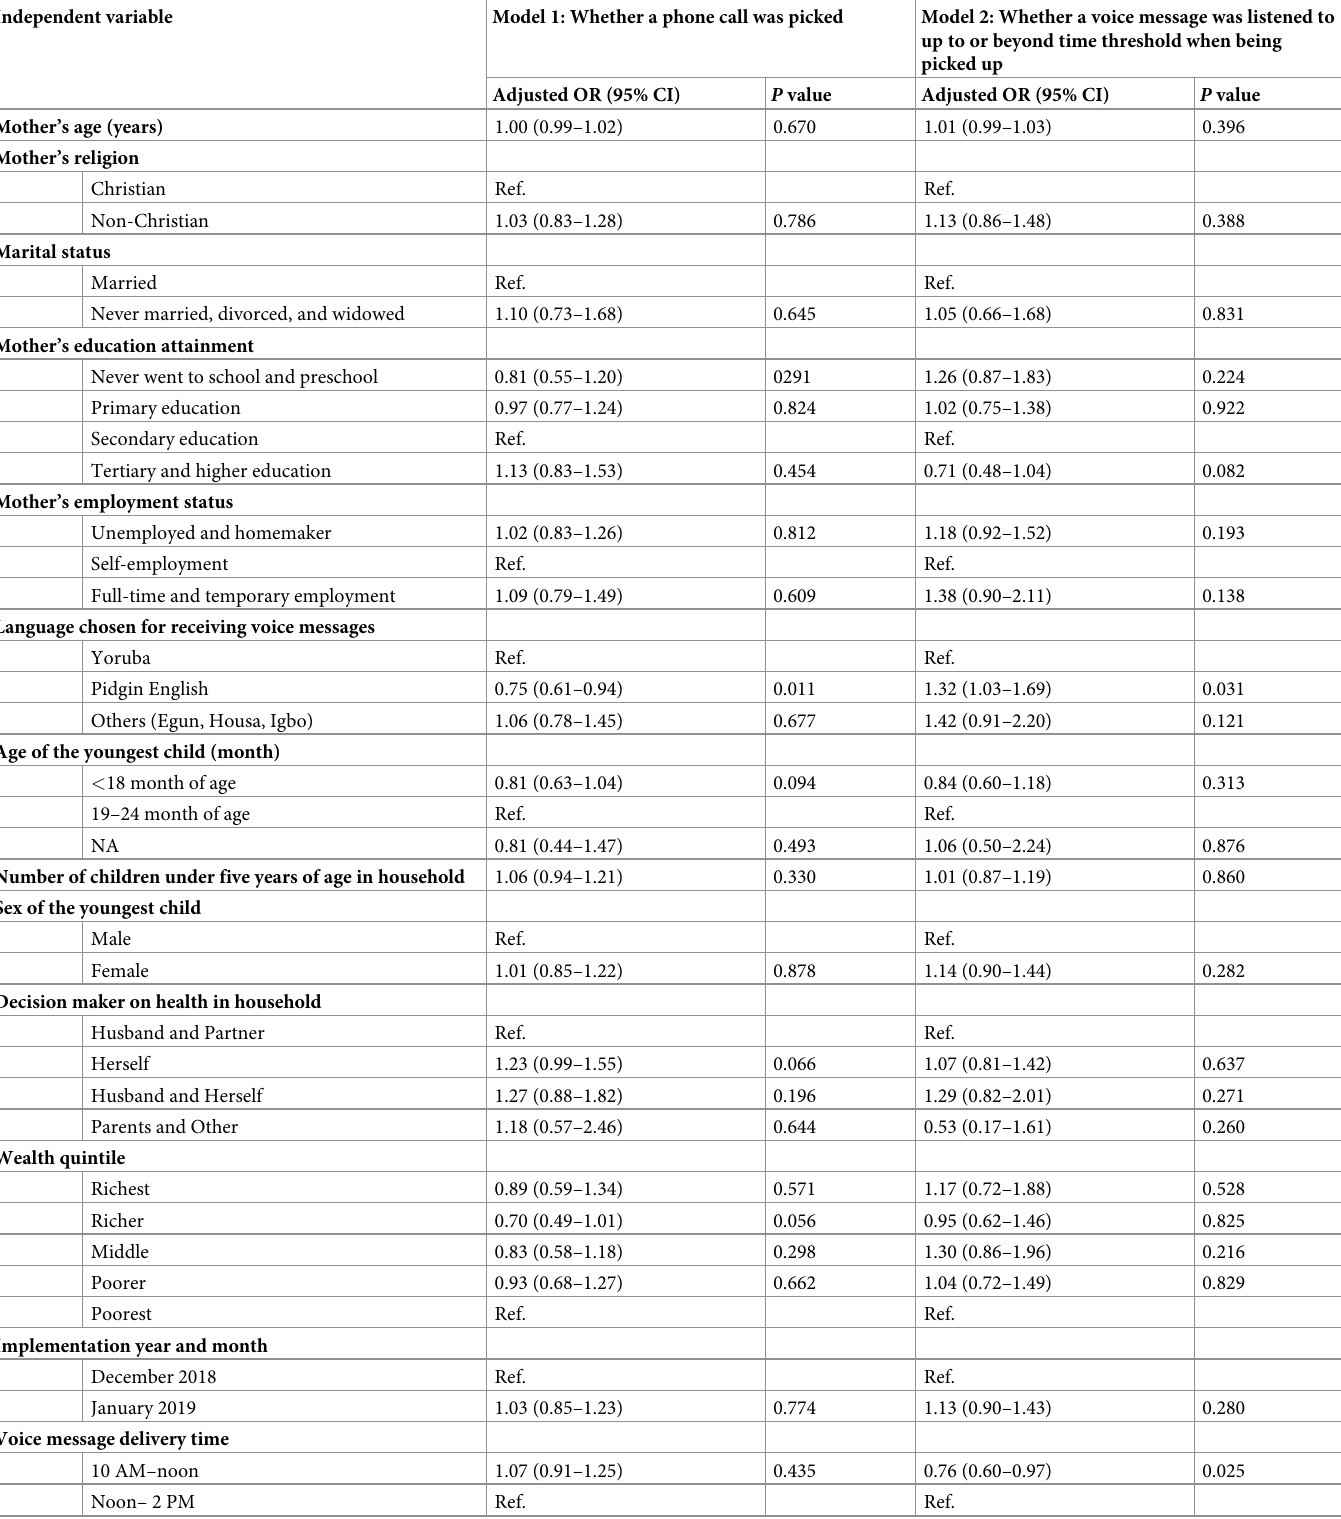
Table 5. Logistic regression models for picking up a phone call (Model 1) and listening to a voice message up to or beyond time threshold (Model